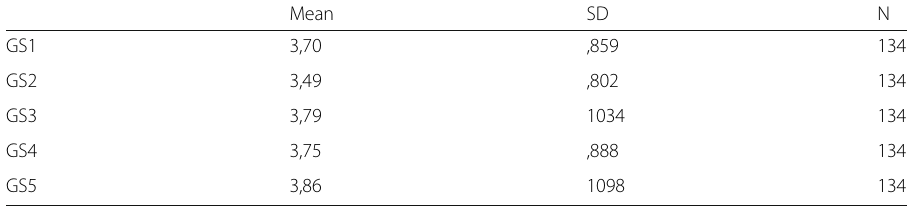
Table 4 Statistics of items on Generic Skills